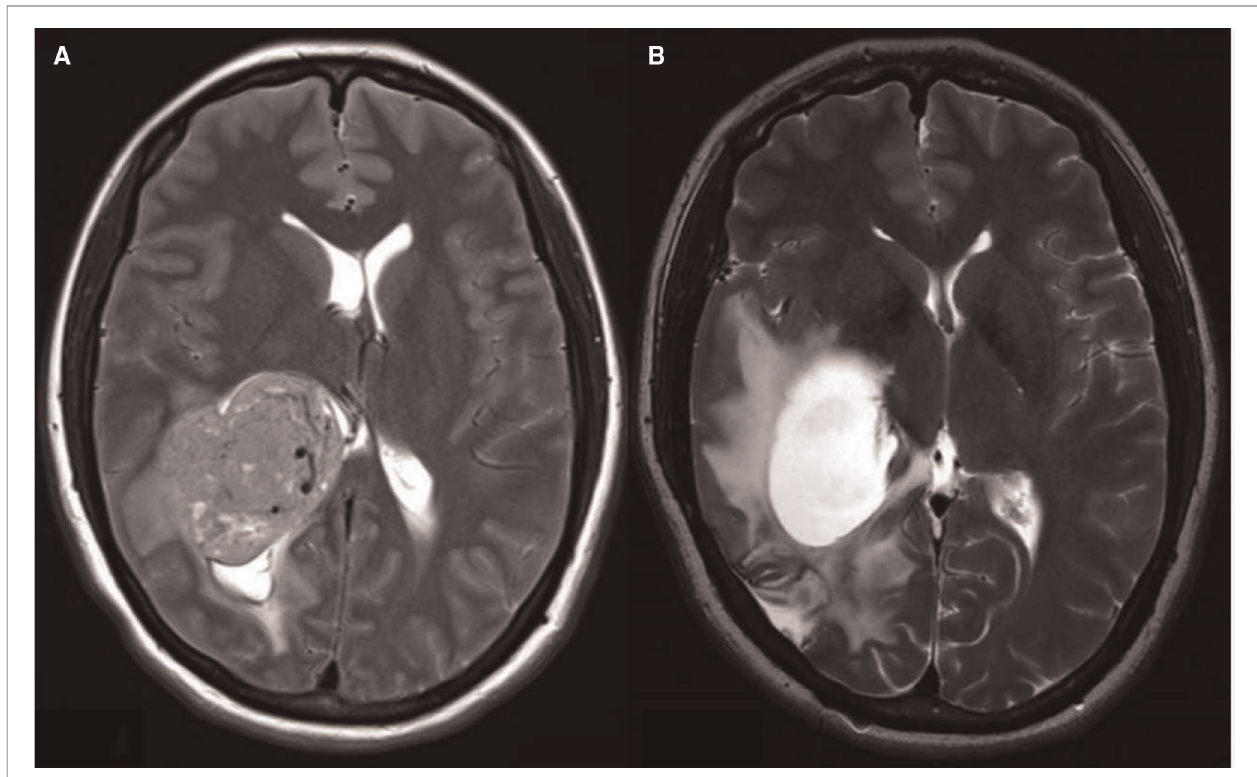
FIGURE 4 | ( A ). Preresection axial T2 image showing the right lateral ventricular tumor, ( B ). Postresection axial T2 image showing the isolated